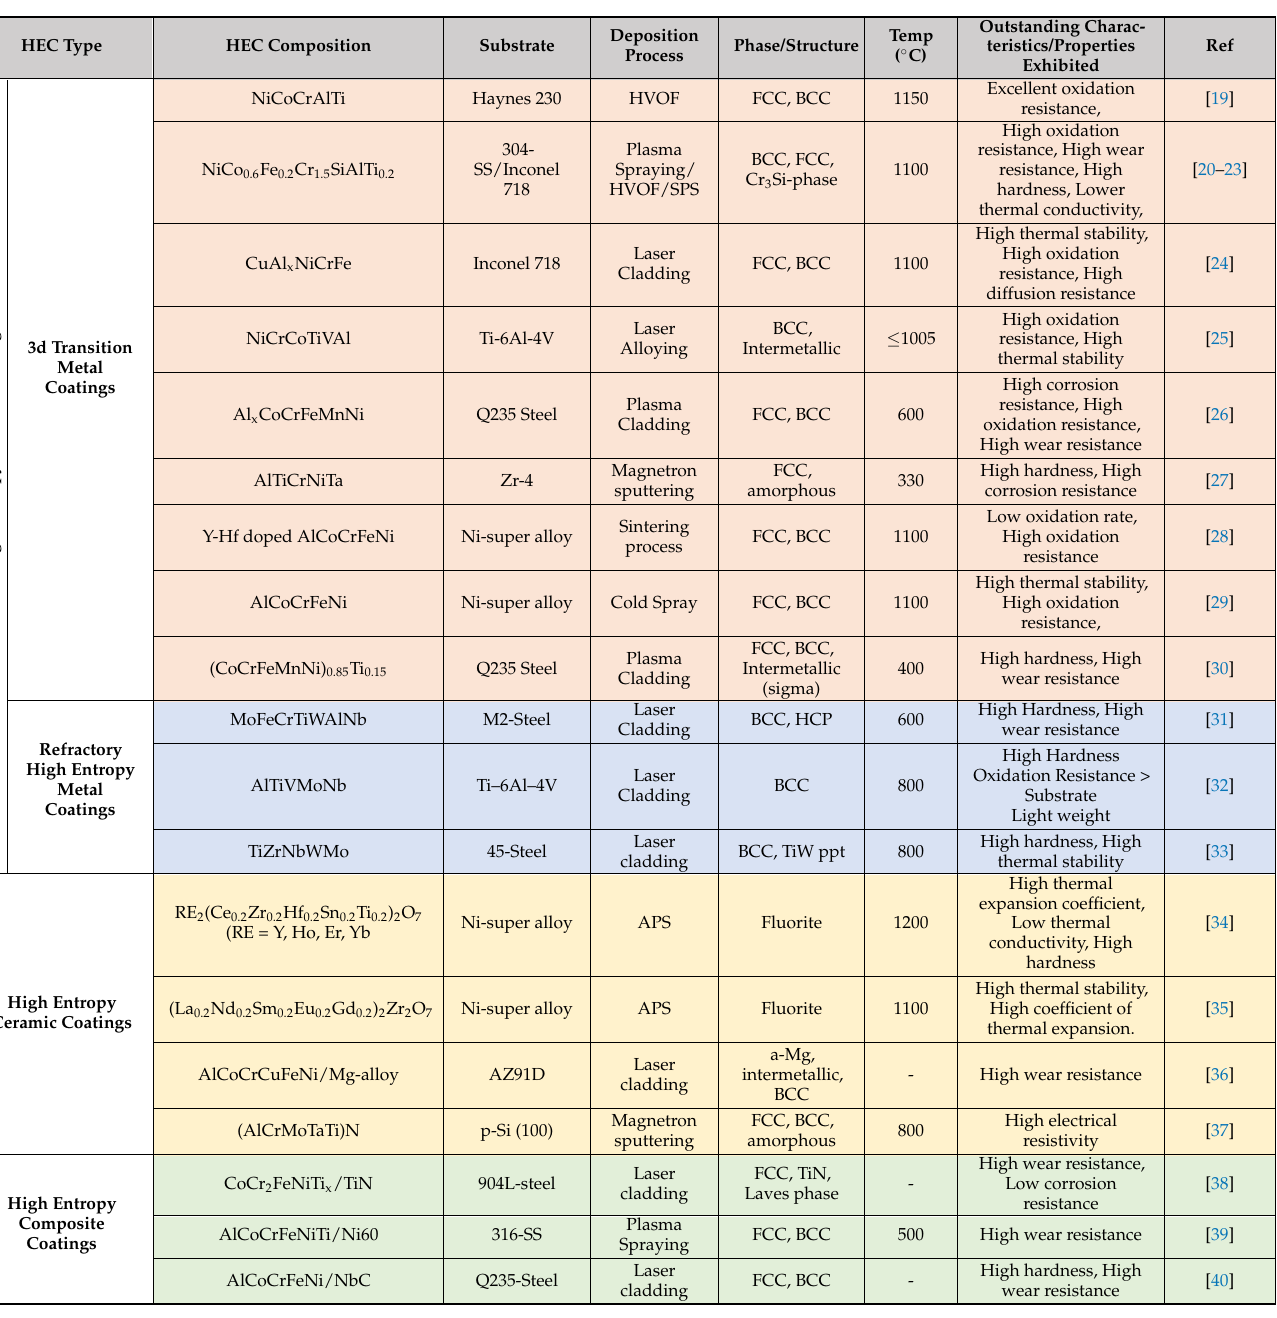
Table 1. Summary of different high-entropy-based coating materials deposited by conventional coating deposition techniques investigated for desired